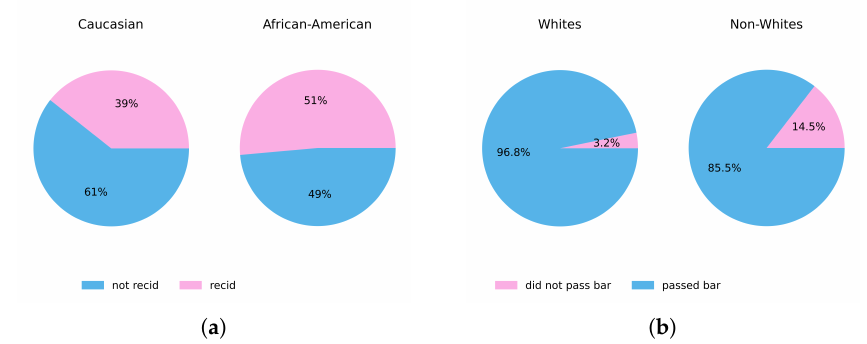
Figure 2. Label distribution according to protected feature. ( a ) COMPAS; ( b )